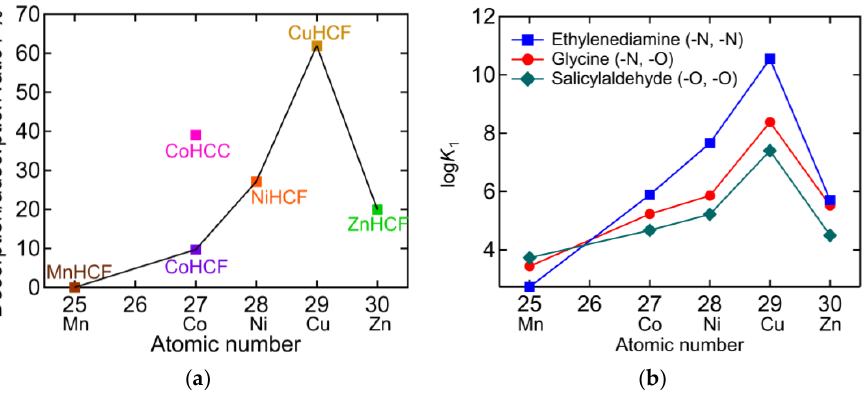
Figure 9. ( a ) The desorption/adsorption ratio plotted against atomic number of M in PBA (A y M[M’(CN) 6 ] x ). Lines connect hexacyanoferrate PBAs showing the same order as the Irving-Williams series [30]. ( b ) Stability constants of divalent transition metal chelate complex [31–36].